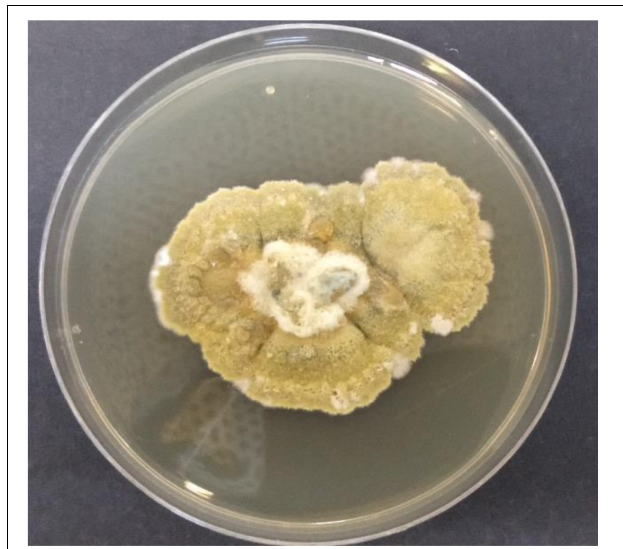
FIGURE 1 | A. unguis AG 1.1 (G) after 10 d growth on PDA plates.